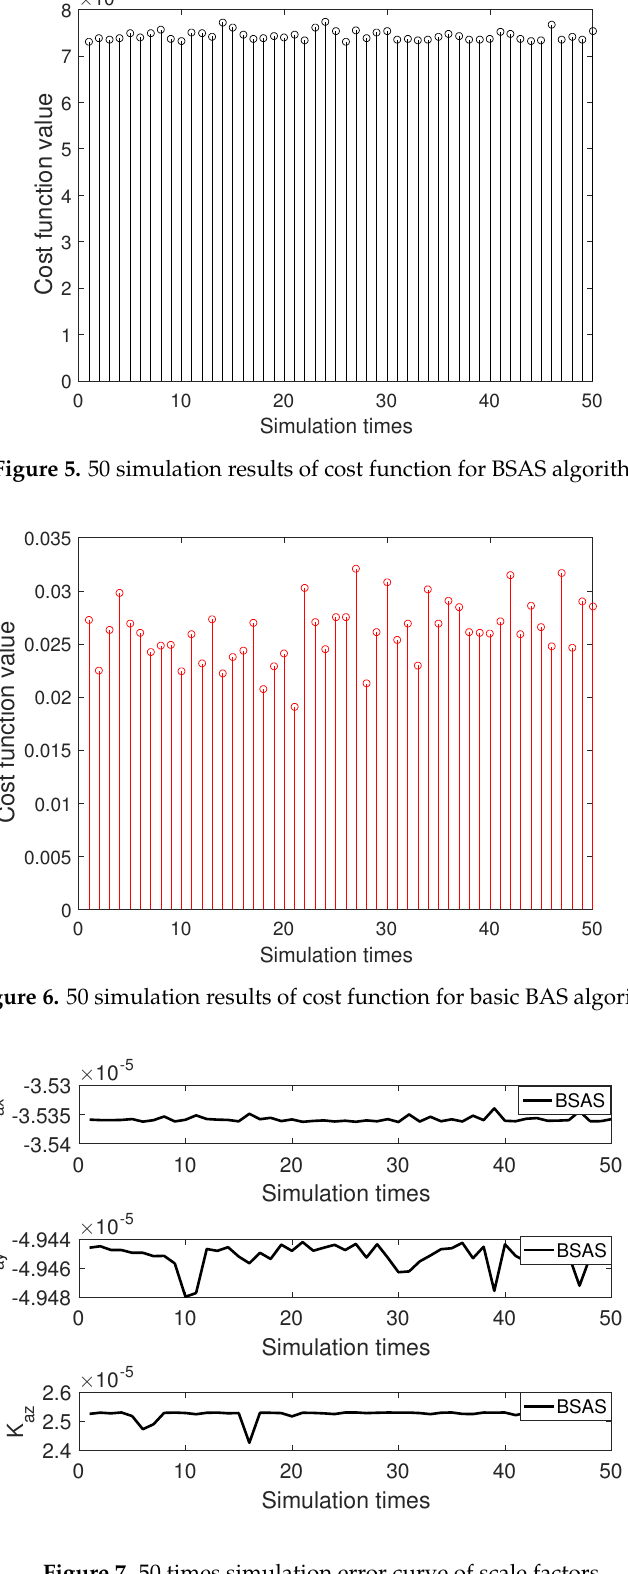
Figure 7. 50 times simulation error curve of scale